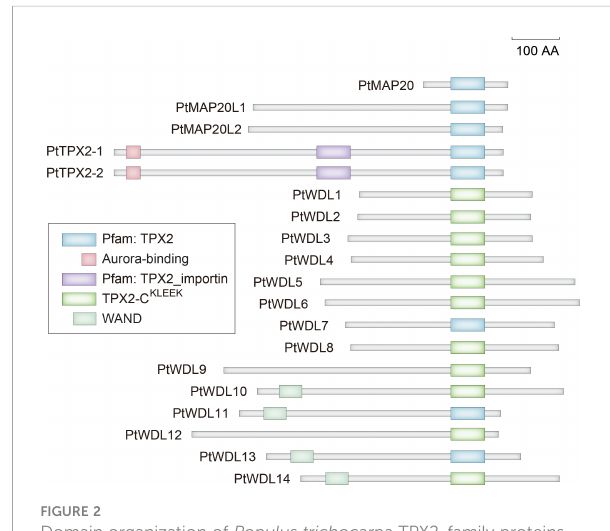
FIGURE 2 Domain organization of Populus trichocarpa TPX2-family